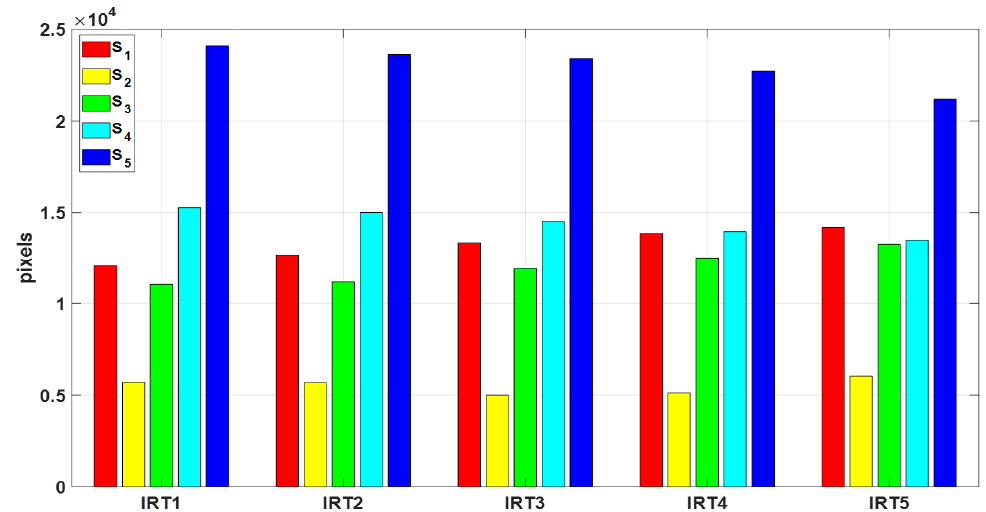
Figure 15. The segmented thermal images produced by the Kohonen map.